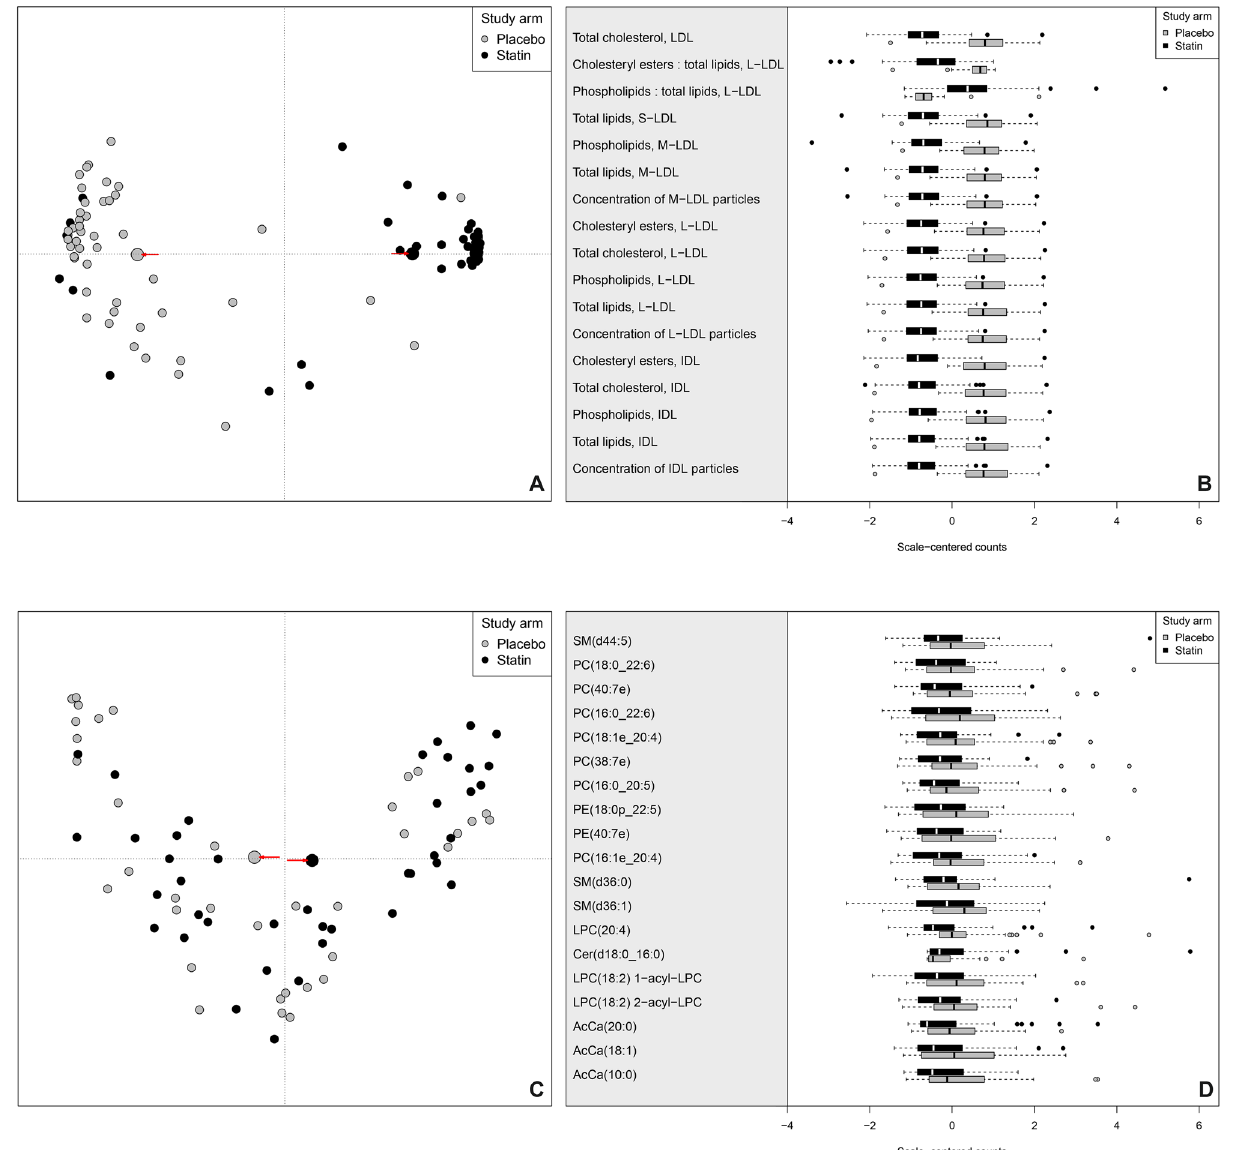
Figure 3. Serum lipoprotein lipid concentrations and intraprostatic tissue lipidome after atorvastatin intervention . ( A ) Proximity plot with serum lipidome after the intervention used as classifier shows clear pattern and distinct centroids (grey and black large points highlighted with arrows), indicating about outstanding classification performance. ( B ) The serum metabolite profile demonstrates differing distributions between the study arms; the median lipoprotein levels are clearly different whereas the dispersions are nearly equal. Note that, one extreme outlying point at − 5.62 in the cholesteryl esters: total lipids, L-LDL statin arm is not visualized to retain visual clarity of the rest of the boxplot. ( C ) The proximity plot with intraprostatic lipidome used as classifier does not result a clear pattern; only at the very tips of the arms few points are clearly clustered among both study arms. ( D ) Intraprostatic lipid level distributions shows slightly differing median lipid levels where statin arm lipid levels are consistently lower than placebo arm lipid levels, except Cer(d18:0 16:0). Moreover, the lipid levels display high dispersion in both arms (wide box, even wider whiskers and far outliers outside 1.5 interquartile baseline serum lipidome and randomization of the study arms, as should be expected. Baseline lipids did not demonstrate statistically significant median difference between the study arms after Benjamini–Hochberg adjust- ment (all p -values are close to 1). Thus, the randomization of the treatment arms was conducted successfully. After the atorvastatin intervention, the study arms display clearly distinct serum lipidomic profiles (Fig. 3A). The median classification error is 11.6% (95% estimated confidence interval 10.6–13.6%). The low classification error indicates that there is a clear association between the post intervention serum lipoprotein lipid content and atorvastatin use. The best performing classifier lipids, according to the random forest, are systematically lower